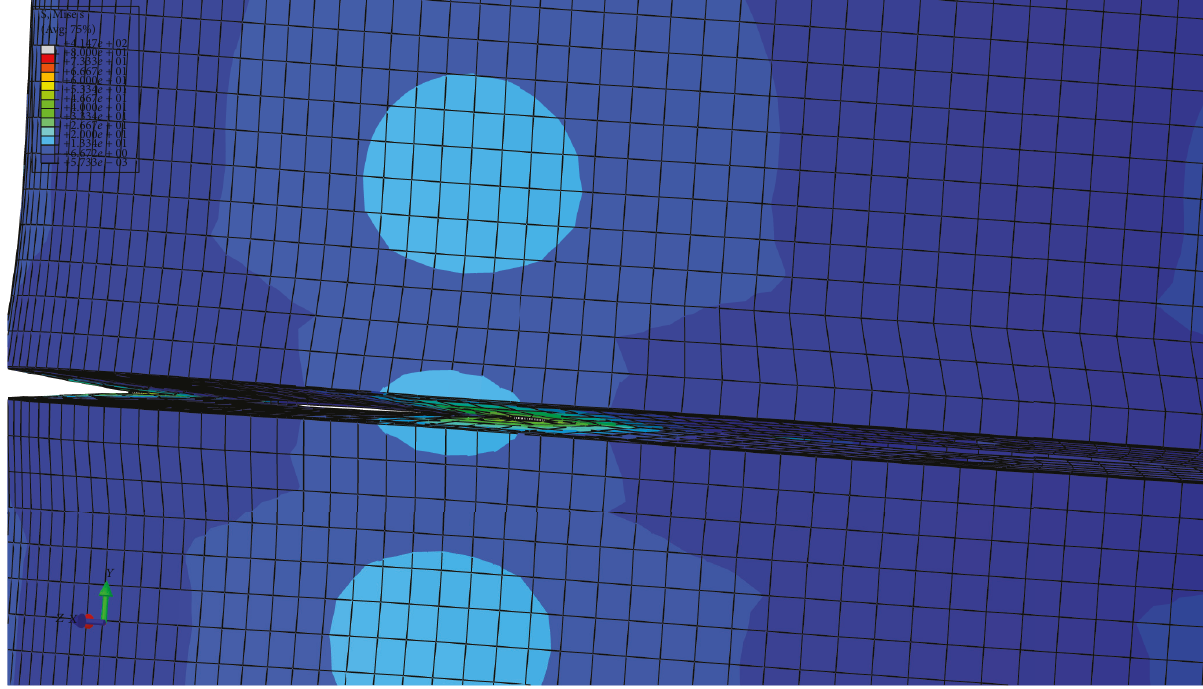
Figure 3: Partial stretch